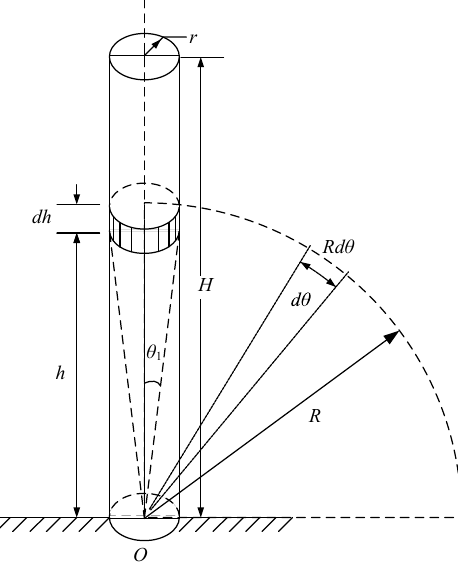
Figure 4. Conical antenna model of an offshore WT tower.